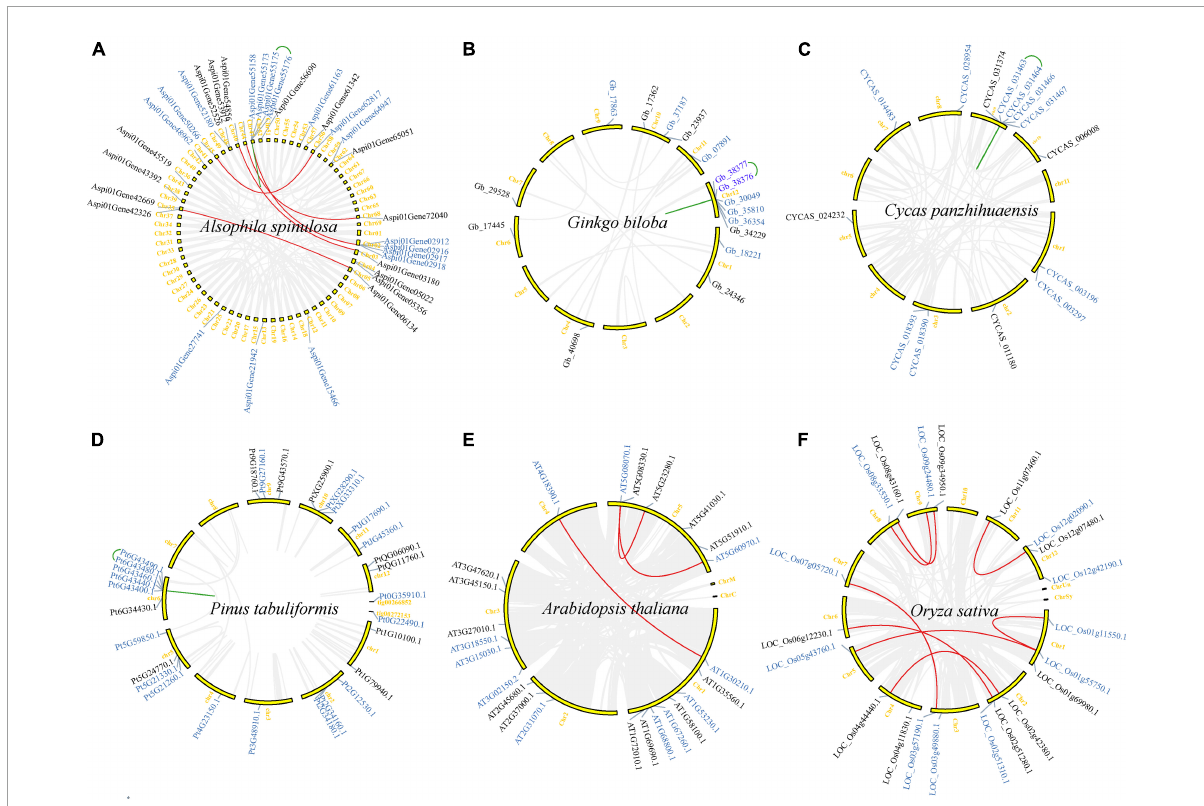
FIGURE5 Synteny analysis of TCP genes in six representative species (A–F) . Gene names on the side of each chromosome correspond to the approximate locations of each TCP gene. The detailed information is listed in Supplementary Table 1 . Gray lines indicate all synteny blocks in the whole genome of each species. Red and green lines suggest TCP gene pairs with segmental/WGD duplication and tandem duplication, respectively. Gene names with black and blue mean Class I and Class II TCP genes,